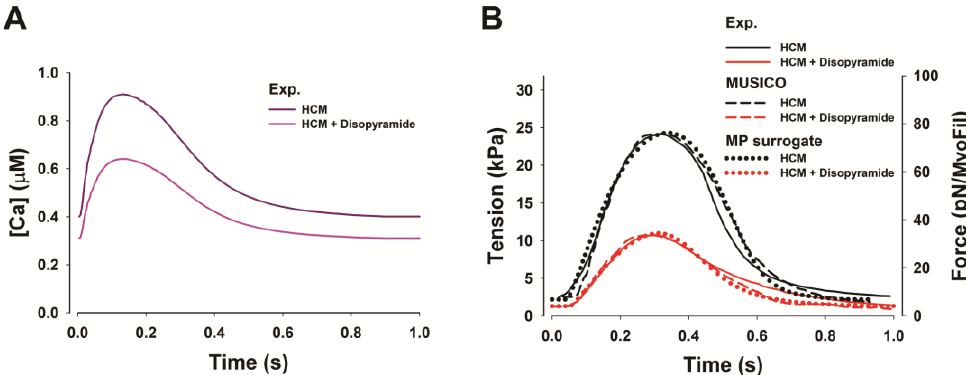
Figure 4. ( A ) Adjusted calcium transients from the observed in human HCM trabeculae [30]. ( B )